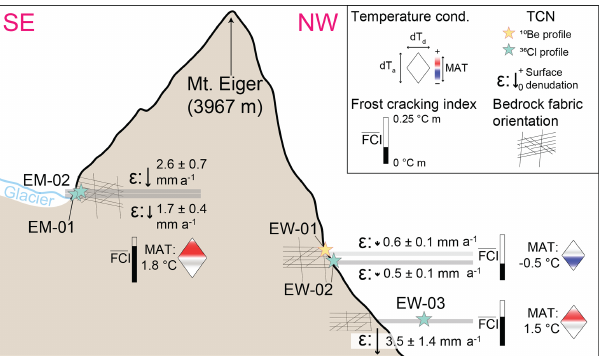
Figure 7. Schematic section (for trace see Fig. 1) with main find- ings. MAT: mean annual temperature; FCI: annual frost cracking intensity index; ε : denudation rate. FCI symbols represent mean modern temperature conditions (Table 4). MAT symbols represent mean modern temperature conditions color-coded with symbol size representing mean annual and diurnal amplitude (Table 1); see text for